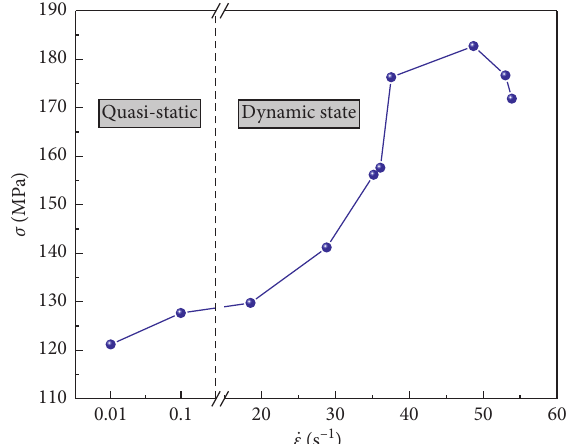
Figure 5: Relationship between compressive strength and strain